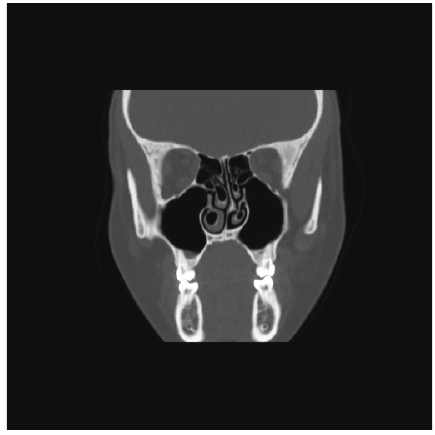
Figure 1: Coronal computed tomography section showing bilateral middle and inferior turbinate pneumatization and nasal septal deviation to left.